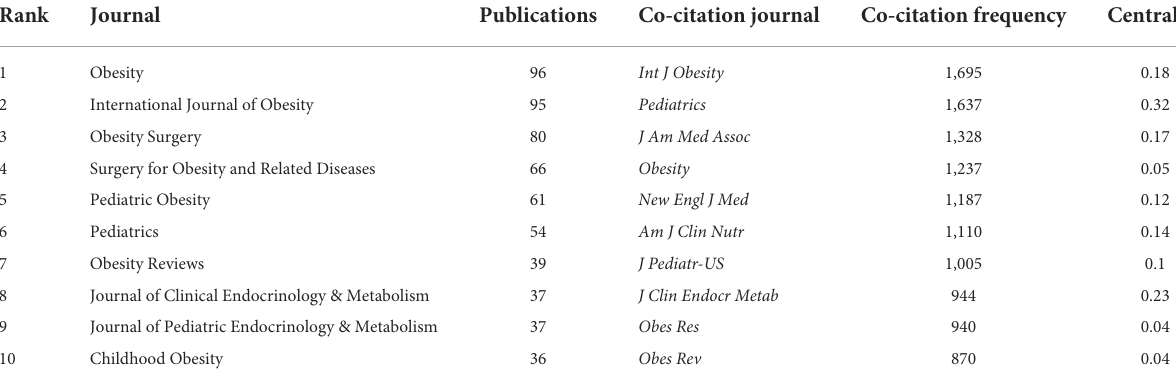
TABLE 3 Top 10 journals and co-citation journals by publications and co-citation